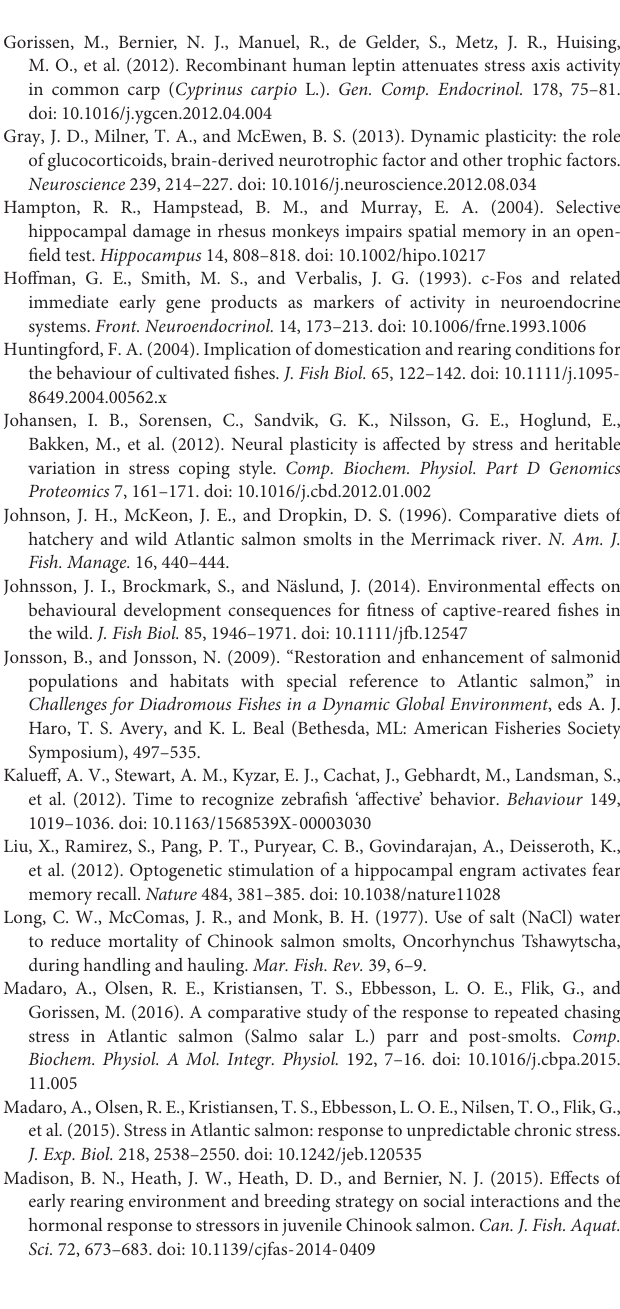
selection tool (A) , the black and white threshold was set to match the original image as closely as possible (B) , and all cells that measures between 15 and 500 pixels were counted by the ImageJ software (C) . Orange arrows indicate the location of a cell which is labeled too weakly to be quantified by the software after adjusting the black and white threshold (B) . PRESENTATION S1 | Sequences of the riboprobes of bdnf and cfos used for in situ hybridization. PRESENTATION S2 | The macro script was used for quantification of labeled cells using the Fiji platform in ImageJ2. DATA SHEET S1 | bdnf and cfos . DATA SHEET S2 | Average number of cfos -expressing cells per